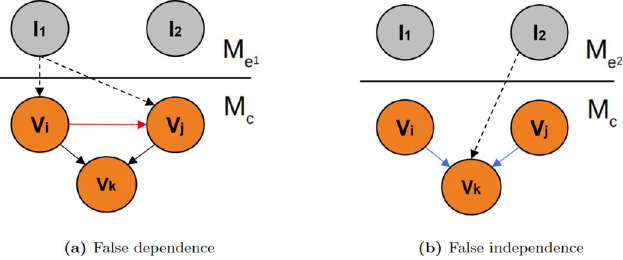
Fig 1. Cross-experiment data pooling leads to network inference errors. Illustration of a simple hypothetical causal model M with three observable entities ( V c experiment M involves intervention I 1 , and experiment M e 1 two experiments can cause two types of network inference errors: false positive edge (shown in (a) as a red arrow between V and V ), and false negative edges (shown in (b) as blue arrows between V i j